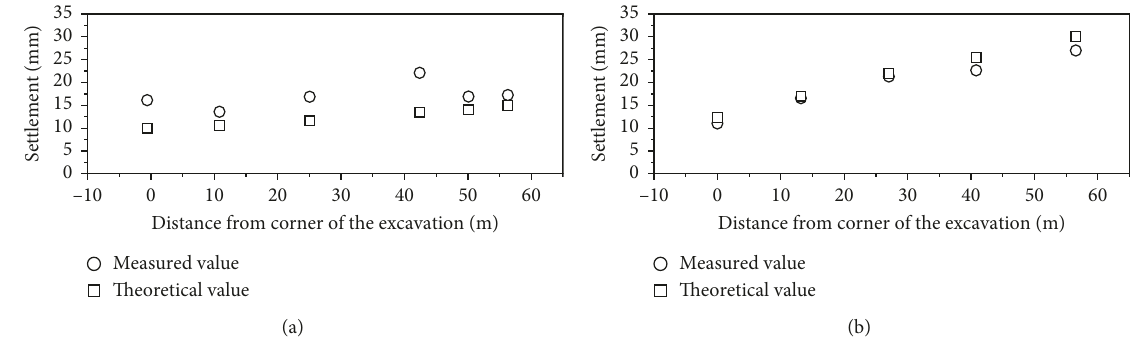
Figure 10: Comparison of theoretical and measured values of Fengqi Road excavation. (a) Side far from excavation. (b) Side near